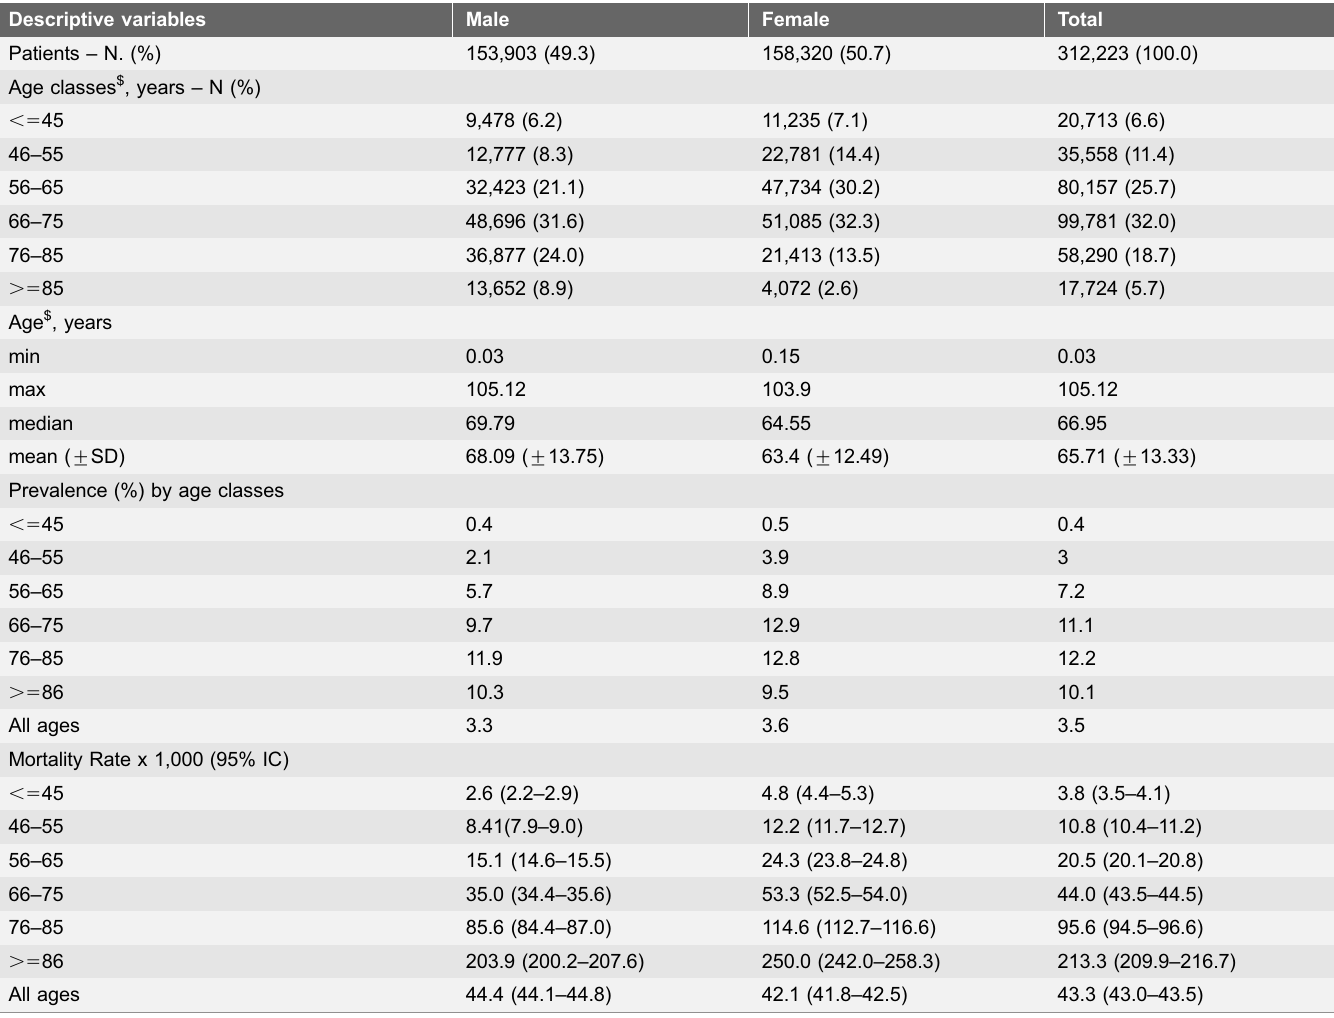
Table 1. Description of study